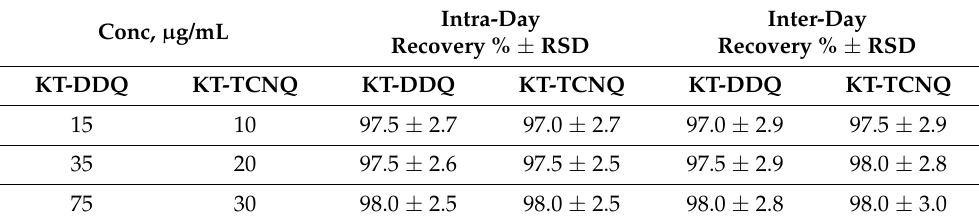
Table 4. Accuracy and precision of the proposed